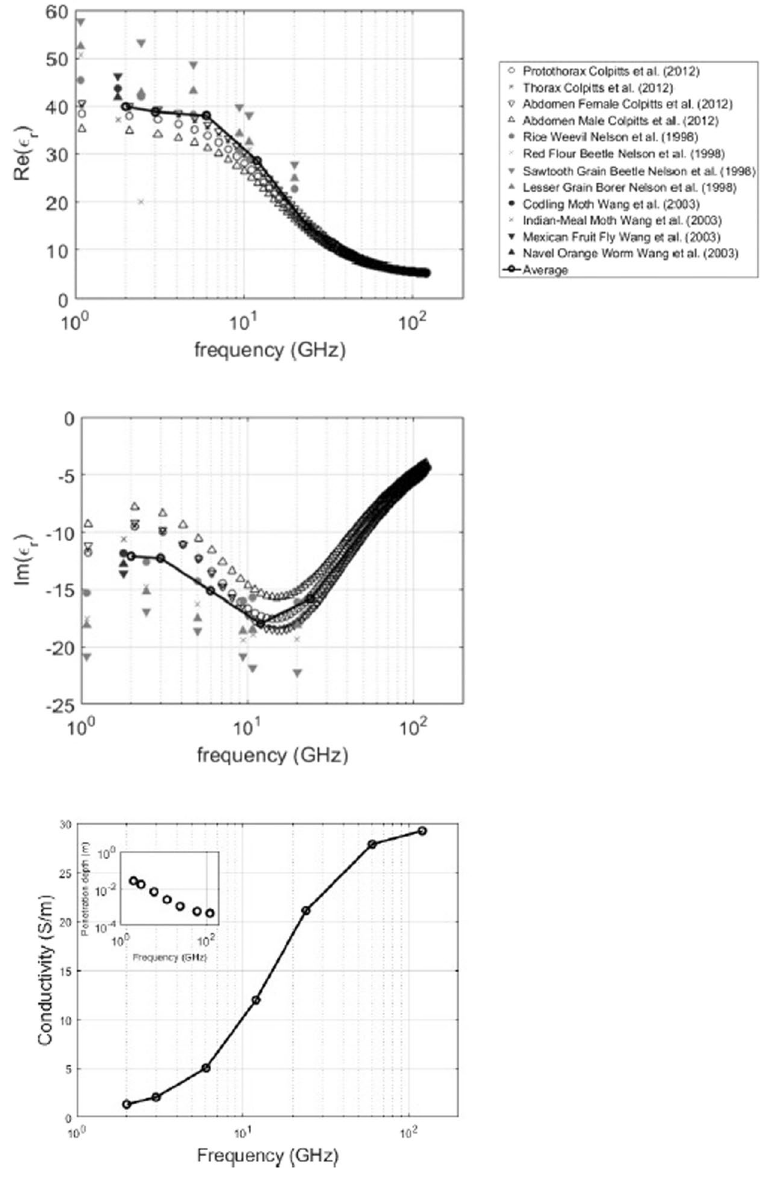
Figure 3. From top to bottom: Real part of the used dielectric permittivity, Imaginary part of the used dielectric permittivity, and conductivity with RF-EMF penetration depth as an inset. Markers show measurements obtained from literature. The black line with circular markers shows the average over the available data series at those